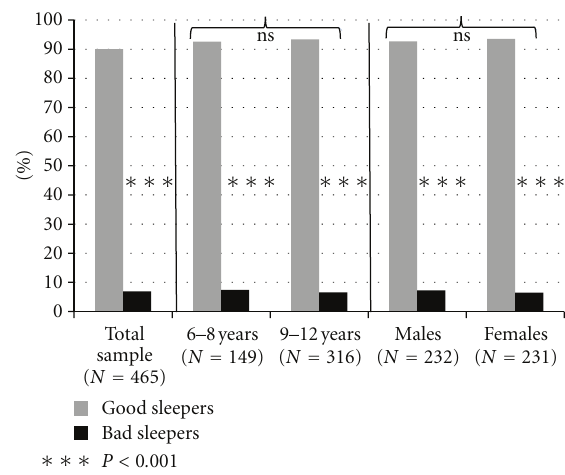
Figure 1: Prevalence of good and bad sleepers in the total sample, in two age groups (6–8 and 9–12 years), and across genders.